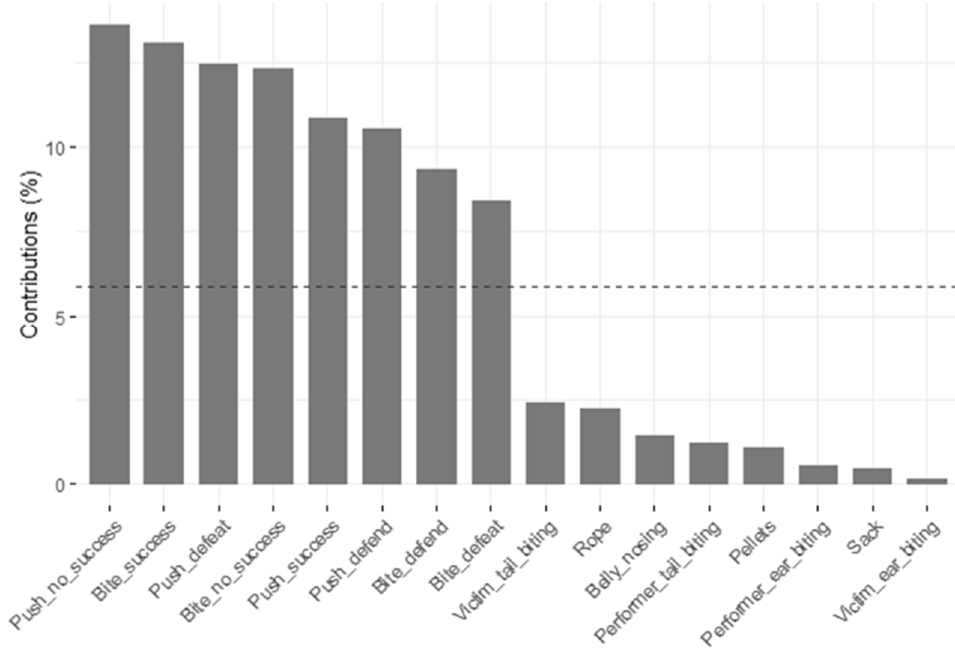
Figure 7. Contribution of variables to principal component factors 1 and 2 for cluster 2; dashed line = expected value if contribution were uniform.